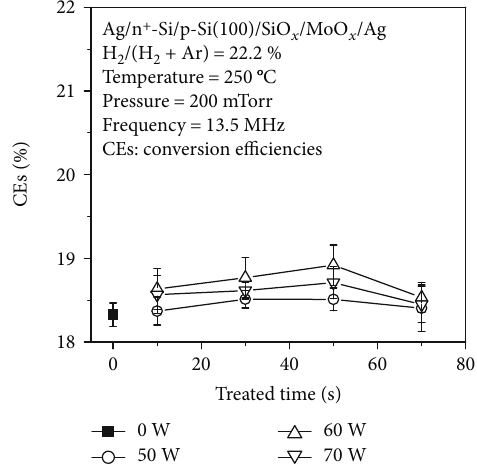
Figure 2: CEs vs. treated time curves of the SPSSCs with and without H /Ar PPT. The H 2 / ð H 2 + Ar Þ ratio and temperature 2 were achieved at 22.2% and 250 ° C,